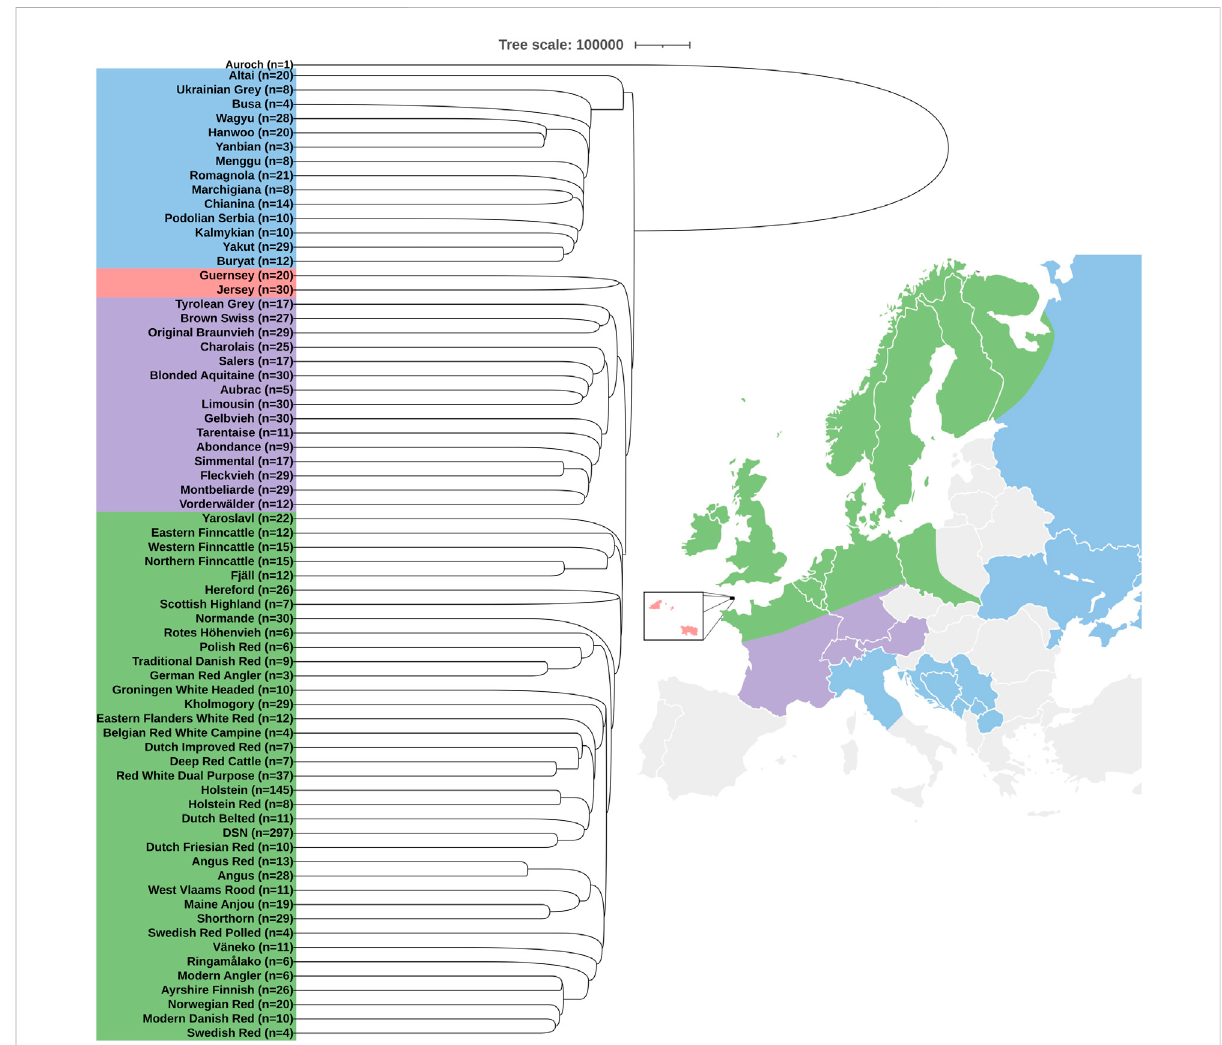
FIGURE 1 Phylogenetic tree and diversity analysis of 69 cattle breeds and Auroch as an outgroup. Colors in the phylogenetic tree represent geographical location of cattle origins: Northern Europe (green), Central Europe (violet), Jersey and Guernsey islands (red), and Eastern Europe together with CentralItalyandAsia(blue).Inparentheses,nisthenumberofanimalsrepresentingthebreed.Countrieswithoutanygenomicbreedinformationare highlighted in